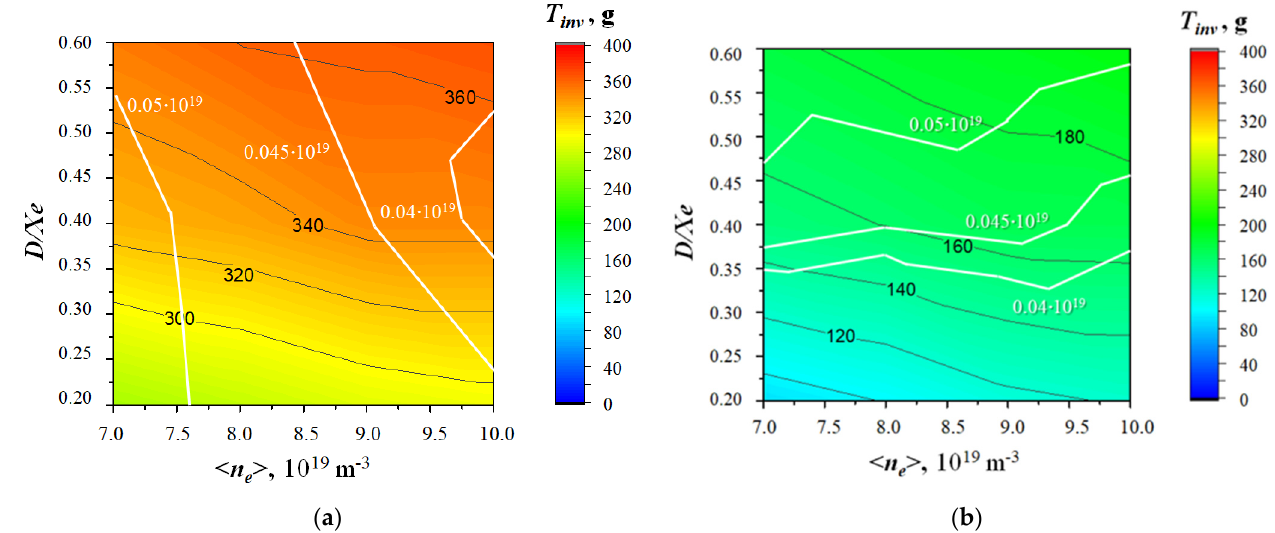
Figure 6. Amount of tritium at the site as a function of the n e and D/ χ e parameters for the ( a ) D + T and ( b ) D beams. The scale on the right shows the correspondence of the color and T inv values. The red lines are the level lines for the neutron flux S neut , shown in Figure 5, and the black lines refer to the accumulated tritium T inv .